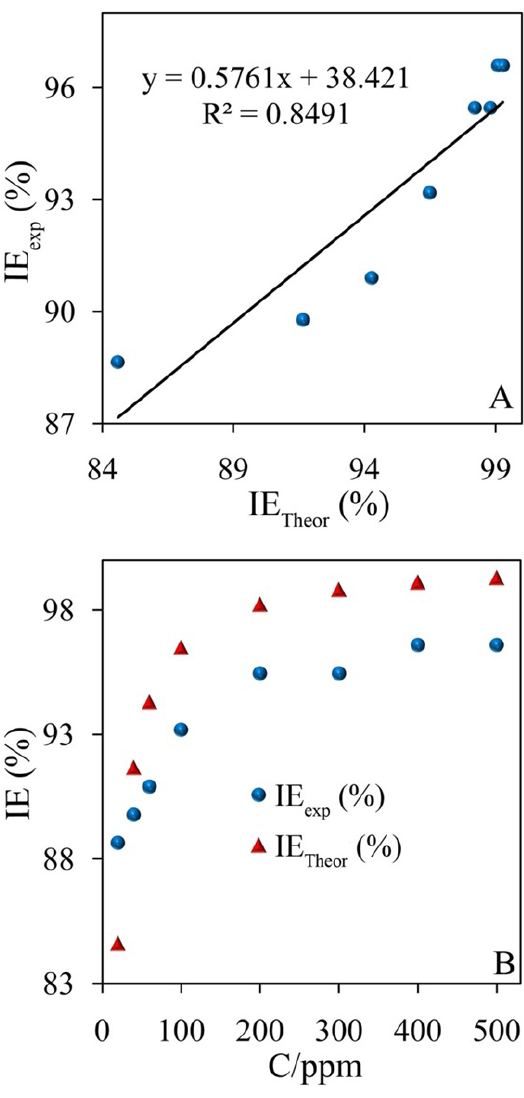
Figure 13. (A) Correlation of experimental and theoretical inhibition efficiencies of 2,2’-(2-Hydroxyethylimino) bis[N-(alphaalpha-dimethylphenethyl)-N-methylacetamide] using the B3LYP/6-31G(d,p) method. (B) Plot of IE IE % versus 2,2’-(2-Hydroxyethylimino)bis[N-(alphaalpha- Theor dimethylphenethyl)-N-methylacetamide]